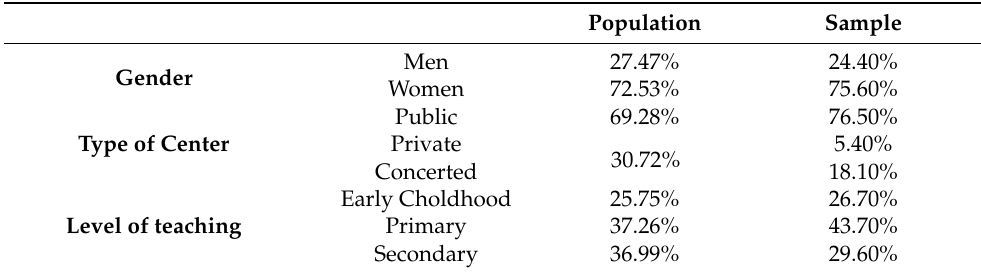
Table 1. Comparative distribution of the study population and sample in terms of gender, type of center, and level of